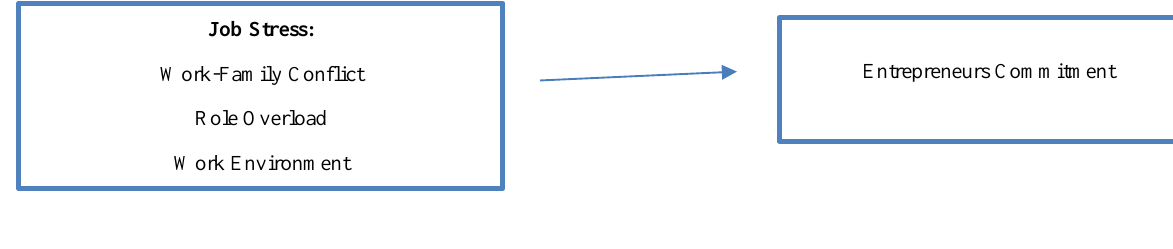
Figure 1: Job Stress